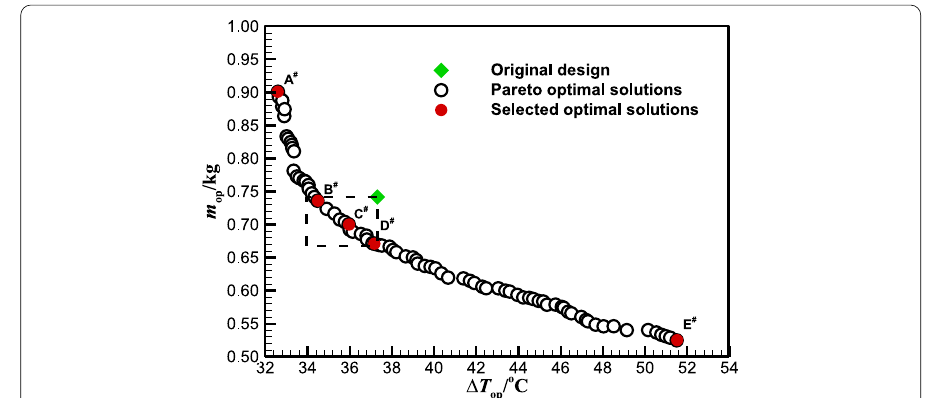
Fig. 9 Pareto optimal solution set and selected optimal solutions